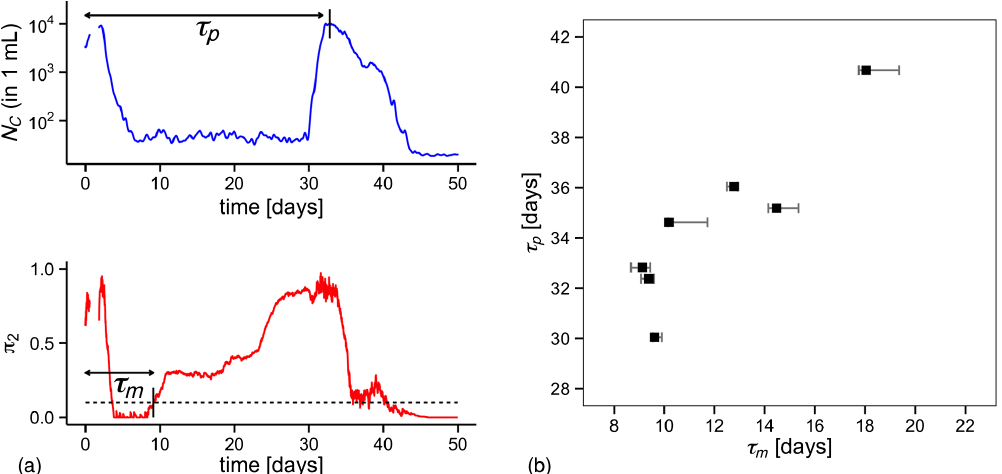
FIG. 3. Morphological dynamics at low illumination. (a) An example of morphological dynamics from a single replicate at low t Þ . Lower panel: The fraction of cells at each time point that are classified as large ( π 2 , see illumination ( I ¼ 0 . 25 I 0 ). Upper panel: N C ð Appendix B 6). The times τ and τ are defined as shown by the arrows (see text for details). (b) Scatter plot of τ p m (a) for 7 CES in the I ¼ 0 . 25 I 0 condition. τ can only be defined for seven of ten replicates in which the peak in N p the remaining three replicates, the large values of τ (not shown) suggest that the peak in N m acquisition terminated. Error bars in τ were computed by varying the threshold applied to π 2 by (cid:3) 25% . The correlation coefficient m between τ and τ is 0.90 ( p ¼ 0 . 006 m p